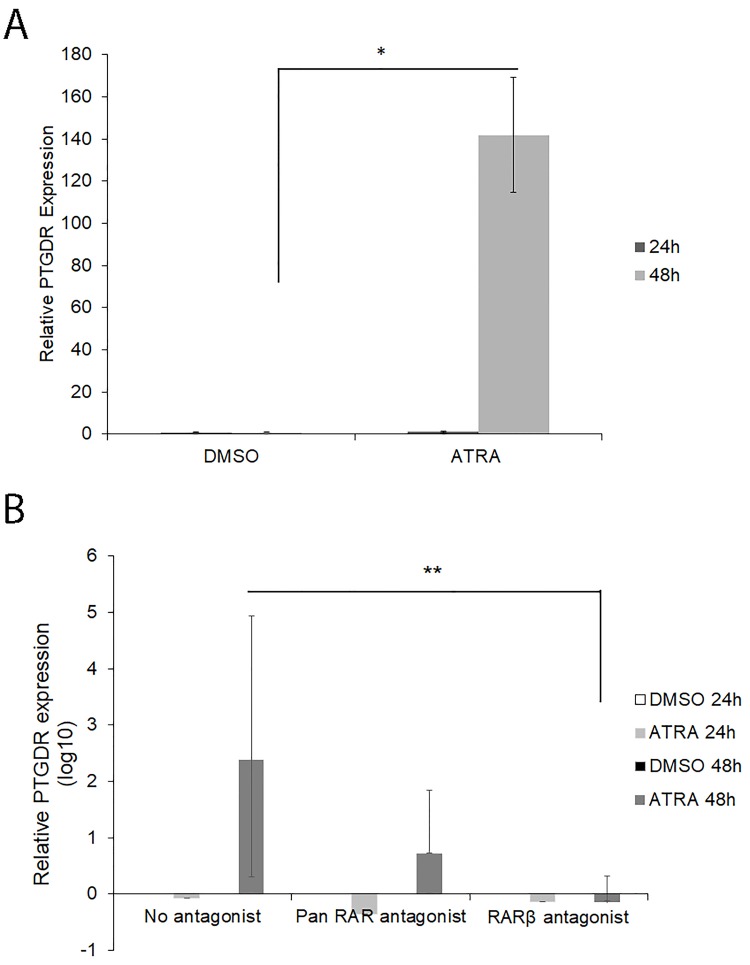
Quantitative real-time PCR analysis of PTGDR gene expression after ATRA or DMSO treatment in KU812 cells.A. KU812 cells were treated with 1 μM ATRA or DMSO and collected after 24 and 48h followed by qPCR analysis as above mentioned. Data are shown as fold increase compared with DMSO (calibrator). * P<0.05 for ATRA treated cells versus DMSO after 48h (Student’s T-test). B. KU812 cells were pre-treated with 1 μM of Pan RAR-antagonist (AGN 193109) or RARβ antagonist (CD 2665) 1 hour before induction with ATRA or DMSO for 24 and 48 h. Cells treated with ATRA or DMSO were used as control. Data are shown as Log10 fold increase compared with DMSO treated cells at the same conditions (calibrator). ** P<0.01 for ATRA 48h no antagonist compared with ATRA 48h RARβ antagonist (Student´s T-test).